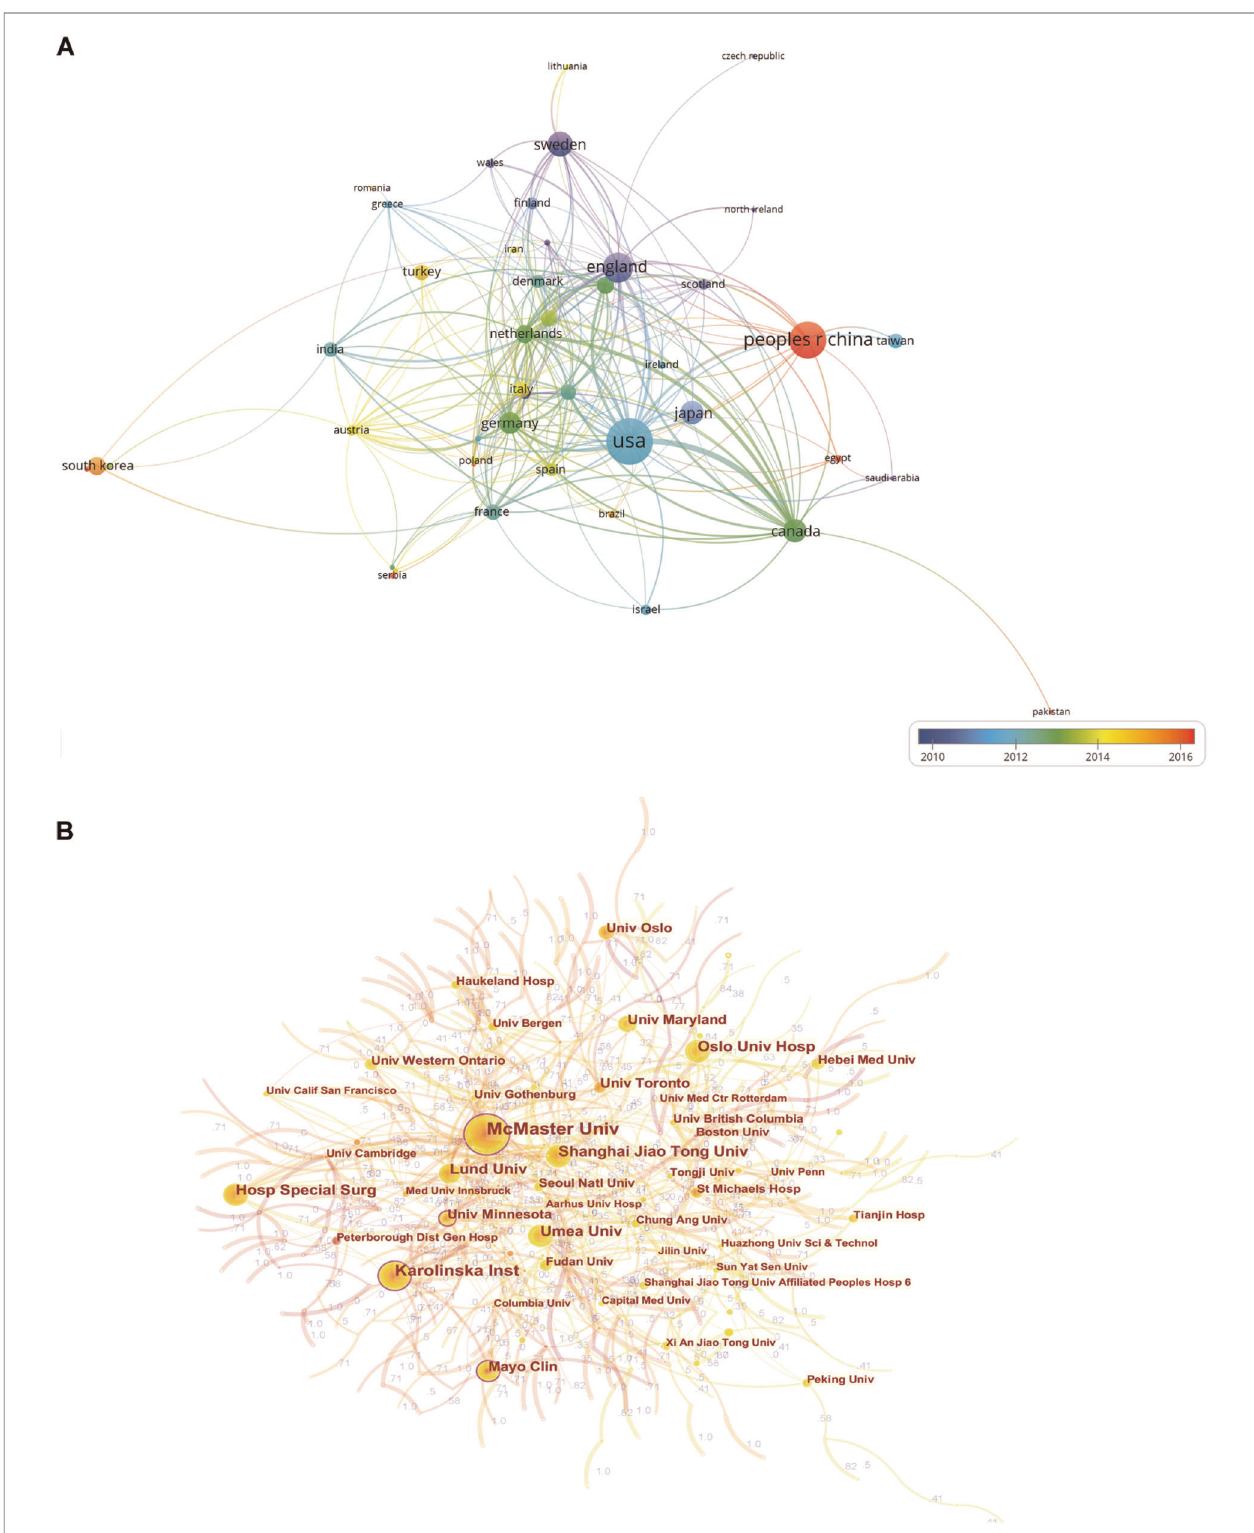
FIGURE 3 | ( A ) The co-authorship map of countries/regions involved in FNF research (generated by VOSviewer). Each node represents a different country, and the node size is proportionate to the number of publications. The color of each node represents the average appearing year (AAY) of the country, depending on the color gradient at the bottom right. ( B ) The cooperation network map of institutions involved in FNF research (generated by CiteSpace). The nodes with a high betweenness centrality (BC)-value ( ≥ 0.1) are indicated by purple rings.